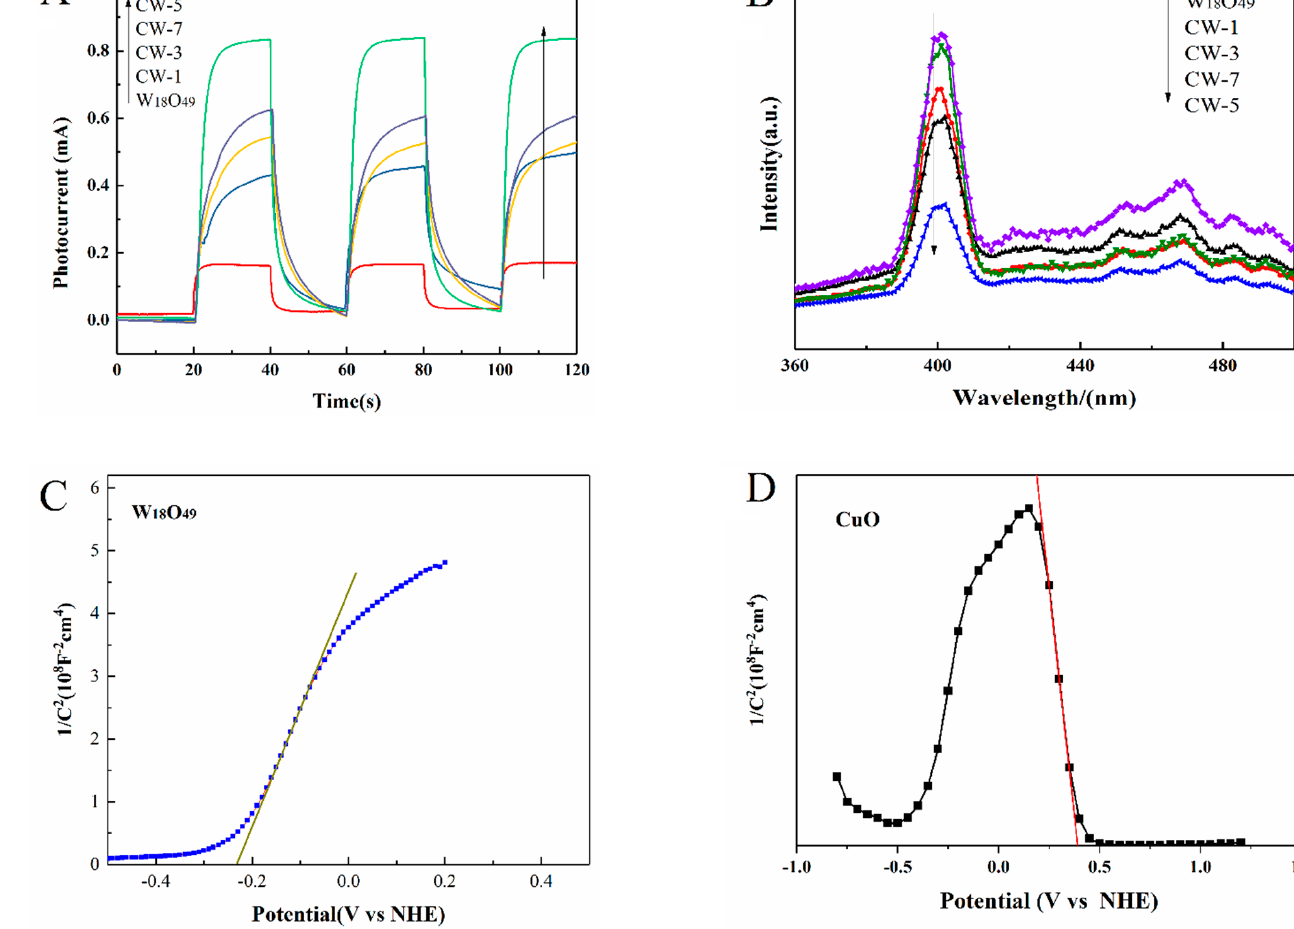
Figure 6. ( A ) Photocurrent generation on the catalyst electrodes coated with W 18 O 49 or CuO/W 18 O 49 samples; ( B ) Pho- toluminescence spectra of different samples; ( C ) the Mott-Schottky diagrams for W 18 O 49 sample ; ( D ) the Mott-Schottky diagrams for CuO sample.